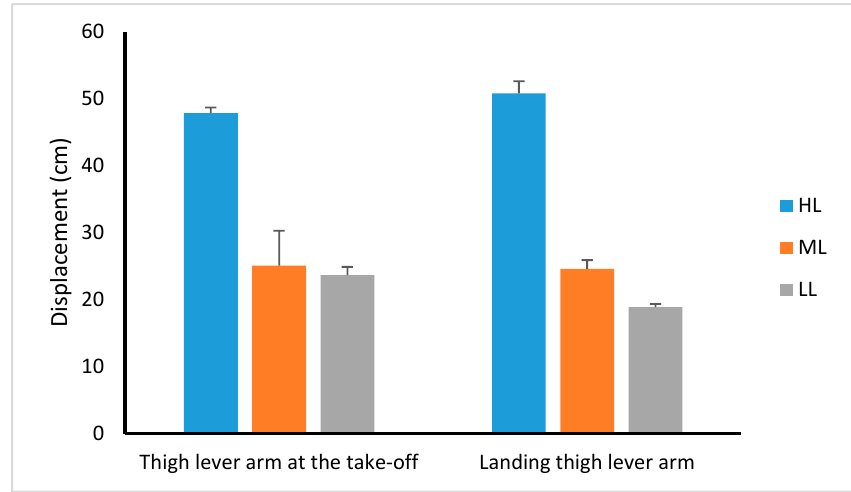
Figure 5. Thigh lever arm (coxo-femoral/knee joints) during the take-off and the landing of the double salchow